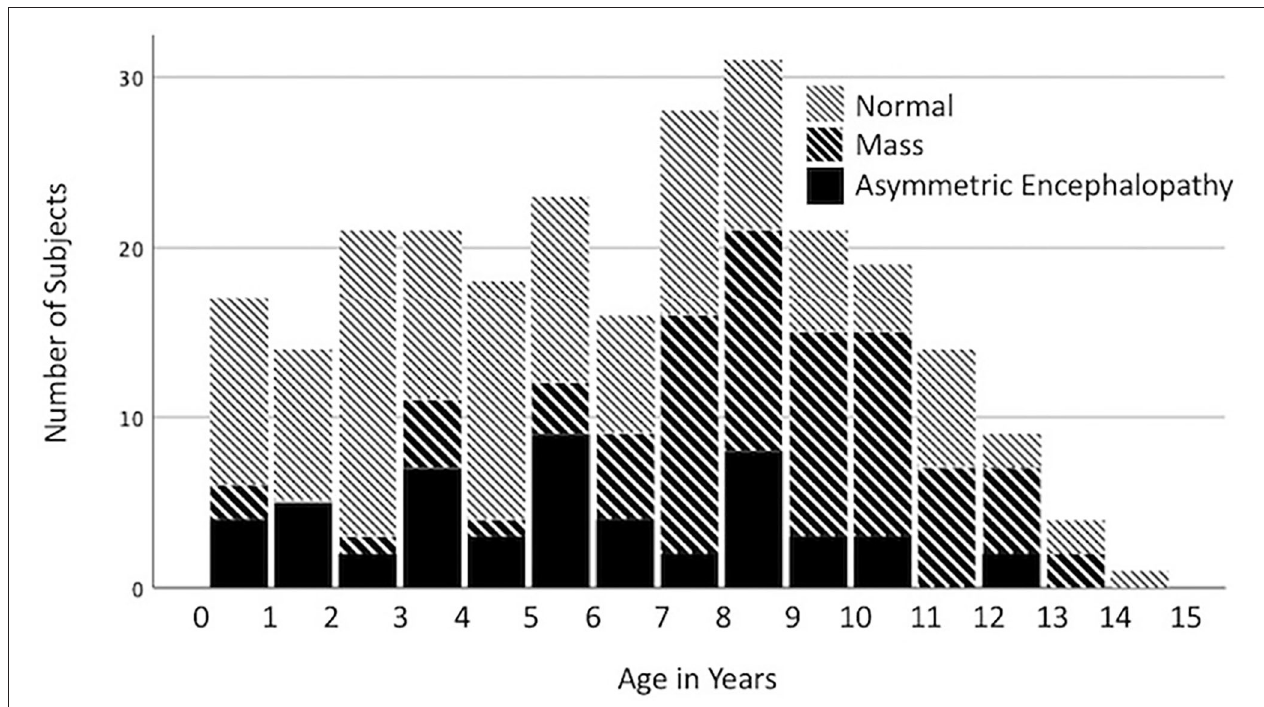
FIGURE 1 | Distribution of the imaging diagnoses, no significant findings (NSF), mass, and asymmetric encephalopathy or meningoencephalopathy (AEM) by age for dogs presenting with